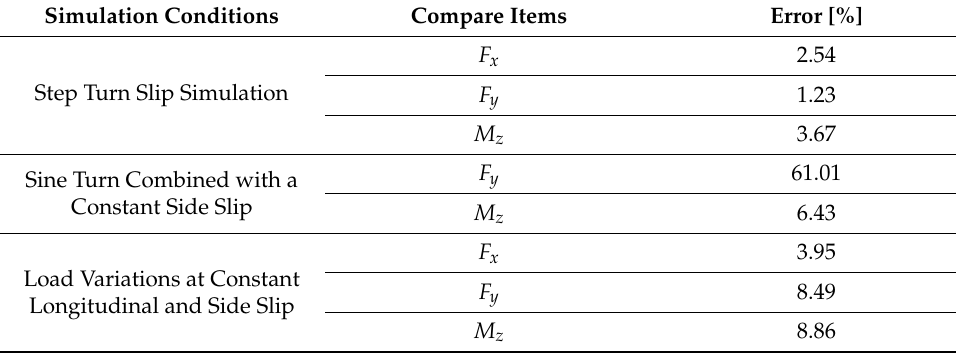
Table 6. The simulation errors at combined slip